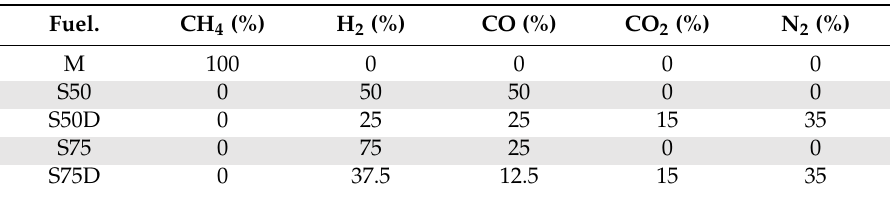
Table 2. Fuel composition on a volume basis.